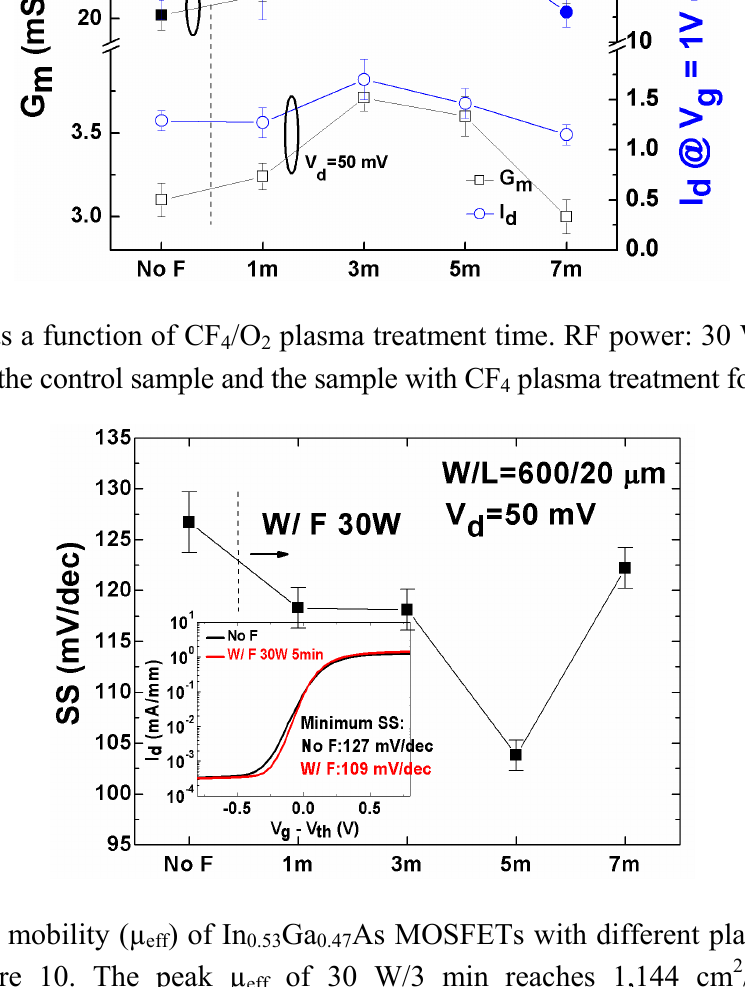
Figure 8. Maximum G (W/L = 600 µm/20 µm at V